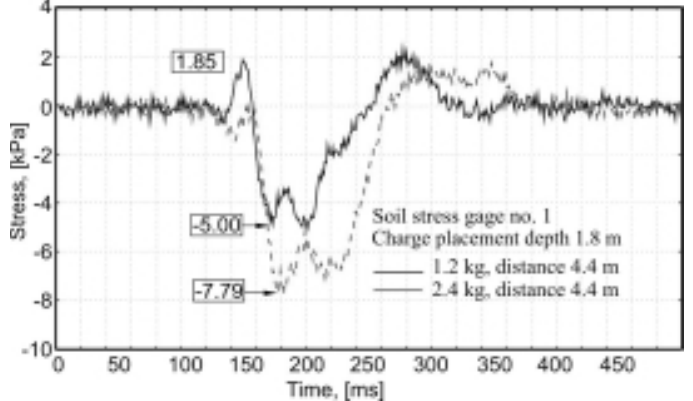
Fig. 9. Soil stress time histories σ h measured by gage No. 1 with the barrier behind.